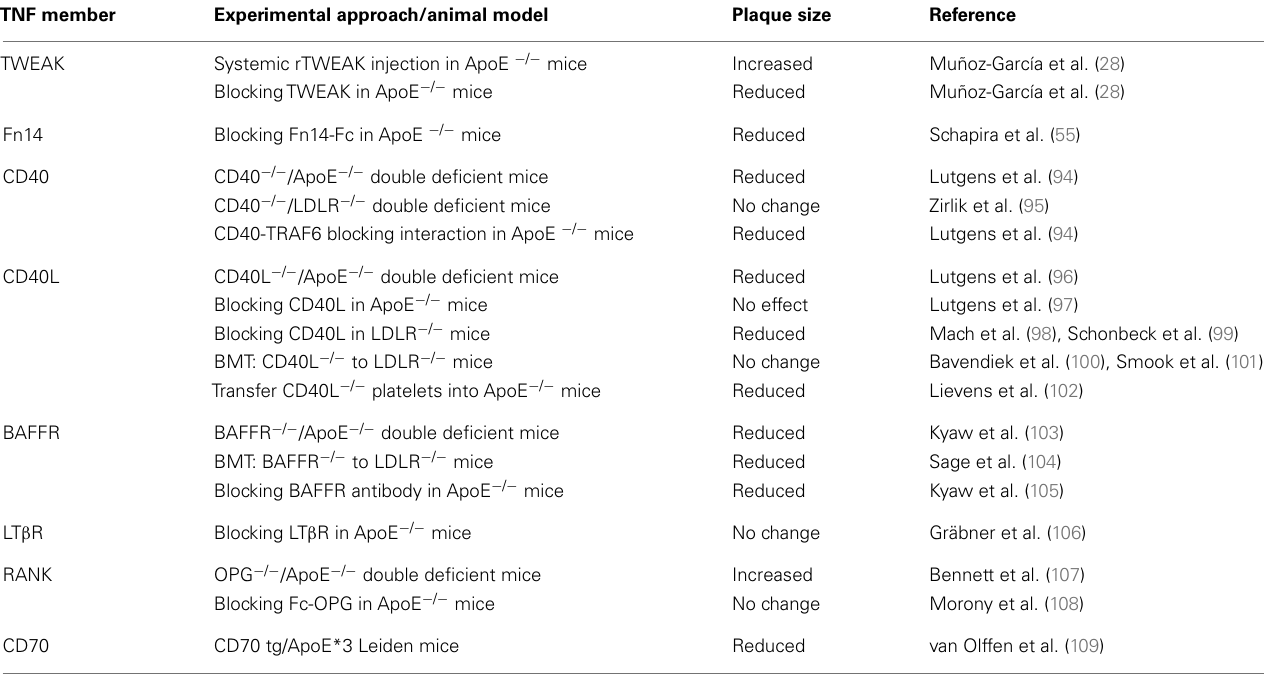
Table 1 | Effect ofTNF superfamily members that activate non-canonical NF- κ B in experimental models of murine atherosclerosis. TNF